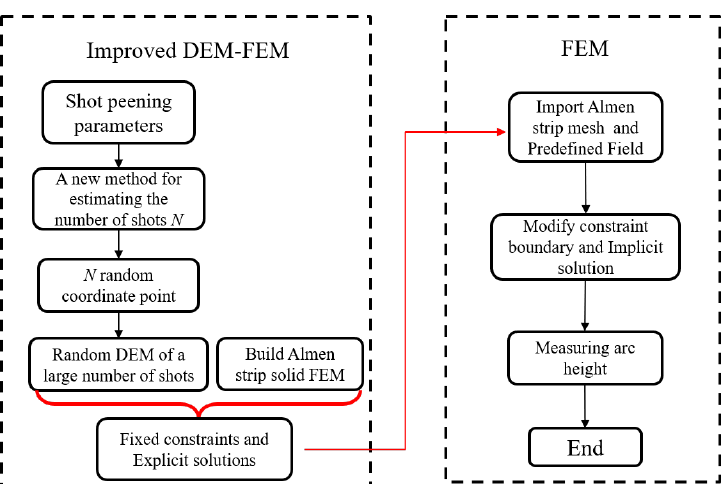
Figure 4. The proposed improved discrete element model (DEM)-finite element model (FEM) scheme of a large number of random shots, which simulates the actual Almen intensity test. The shot stream number is calculated by a new method based on the test and shot peening parameters. The random coordinate point of the shot stream is obtained by Python program. A large and real number of random shots hitting the Almen strip is established in Abaqus/Explicit. The extracted Almen strip mesh and predefined field are imported into Abaqus/Implicit to obtain the spring back.